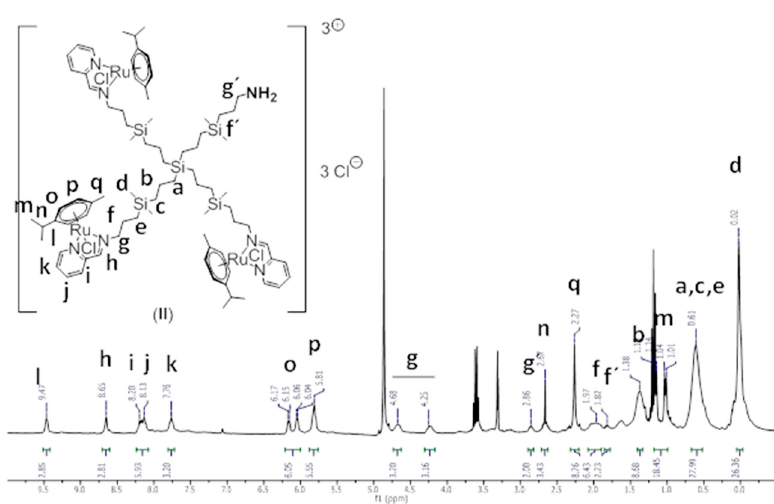
Figure 3. 1 H-NMR spectrum of compound 2 in CD 3 OD.